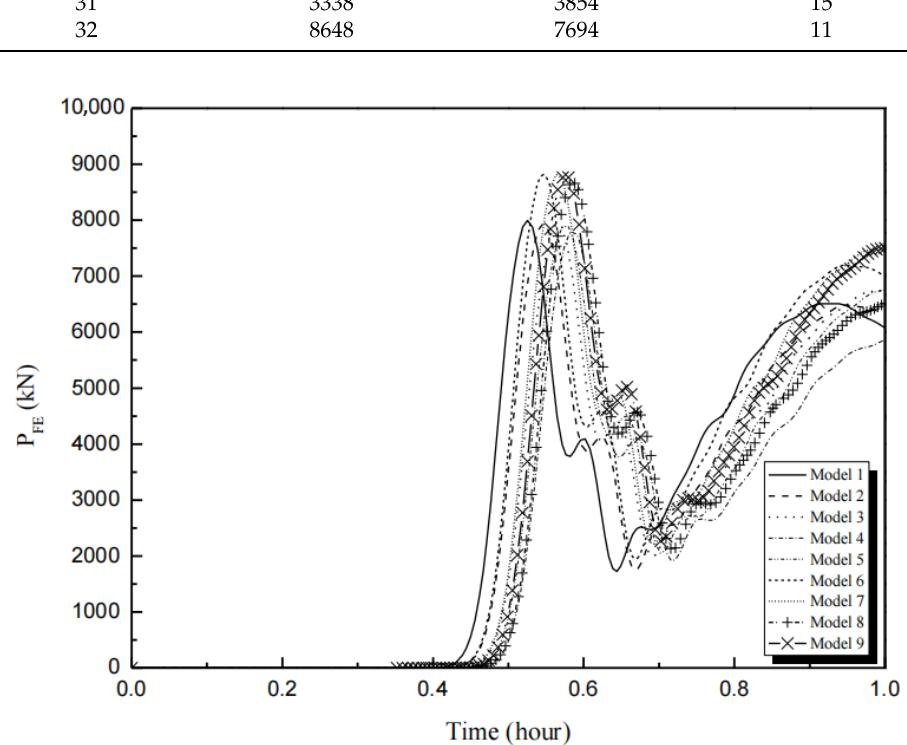
Figure 2 . ( a ) FE modelling of Model No. 1 with PFE 3171 kN; Model No. 2 with PFE 2640 kN;.( b ) FE modelling of Model No. 3 with P FE 7919 kN; Model No. 4 with P FE 7928 kN;.